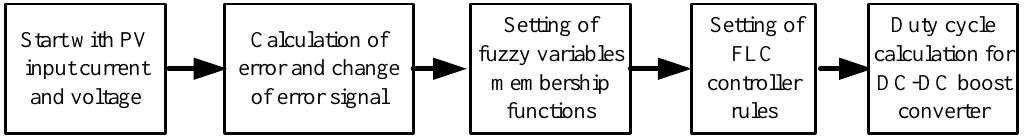
Figure 3. Flow chart of fuzzy logic controller (FLC) controller.